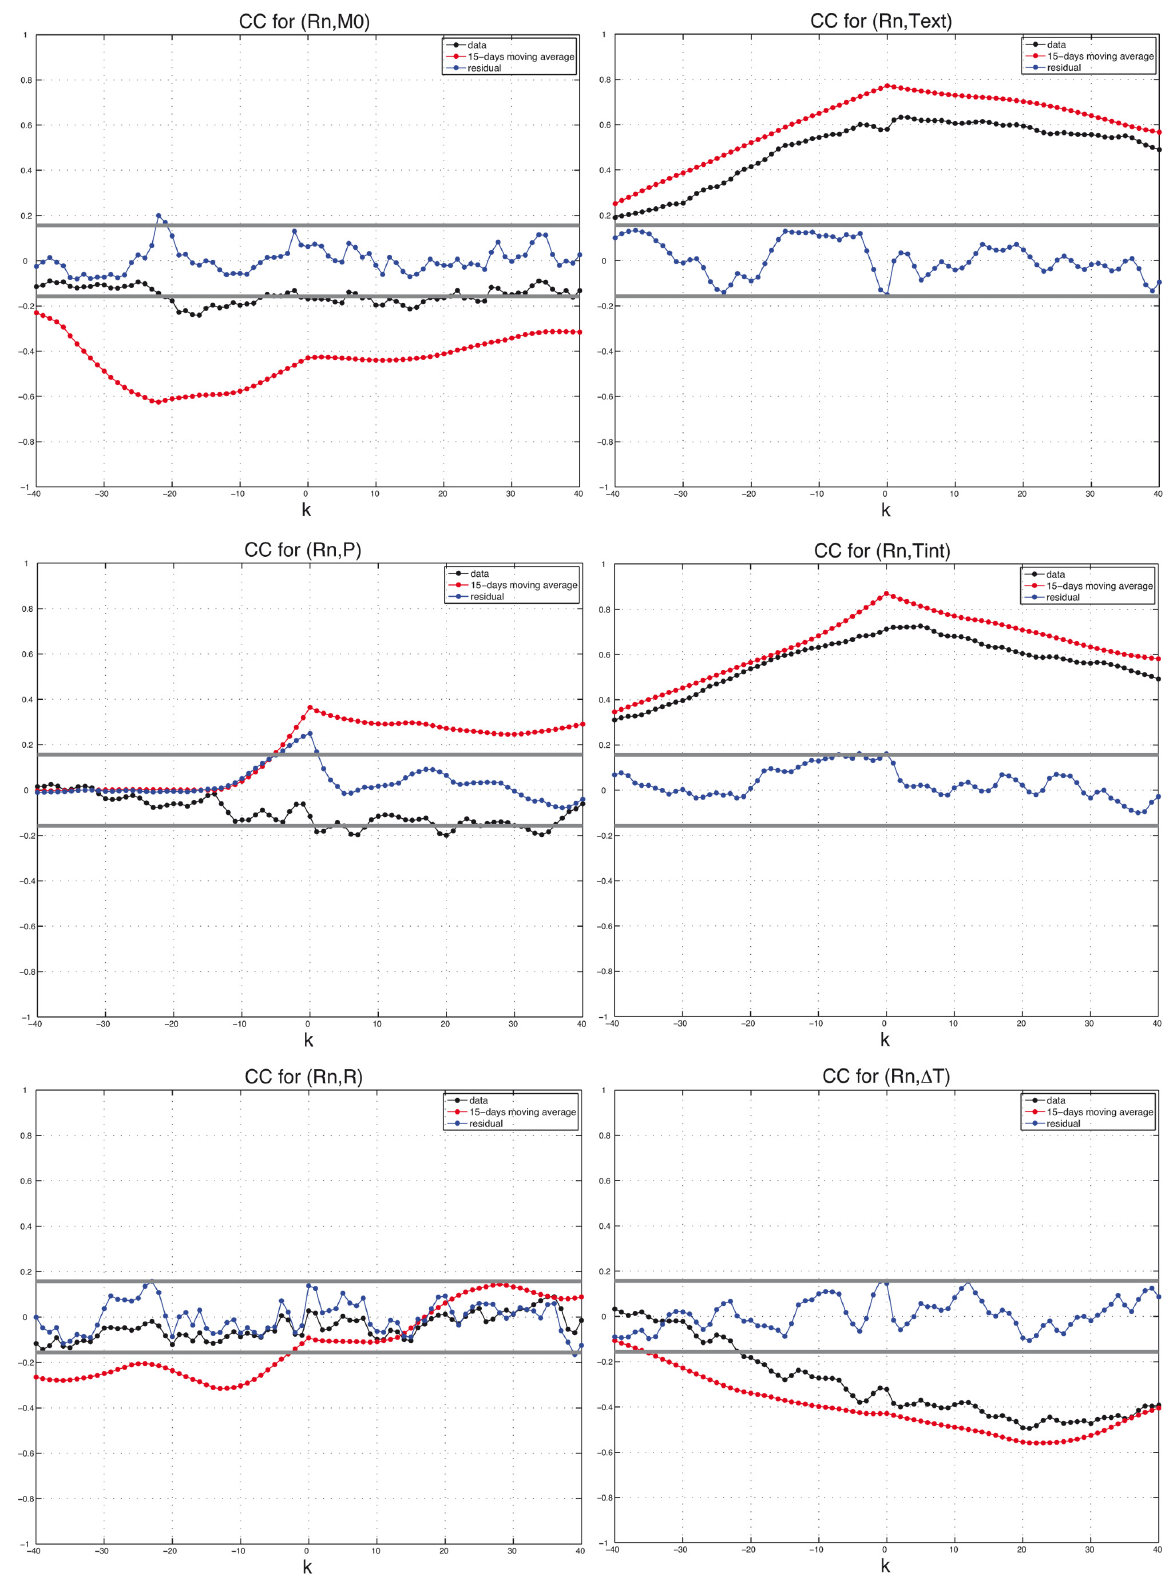
Figure 8. Cross-correlation function (CC) for the segment January 1, 2011 - December 31, 2011 between radon time series Rn and time se- ries of one of other variables (cumulative seismic moment release M cipitation R). The CC is evaluated between unfiltered data (black-pointed line), 15-days moving average (red-pointed line) and their residuals (blue-pointed line). Horizontal gray lines represent 99% confidence